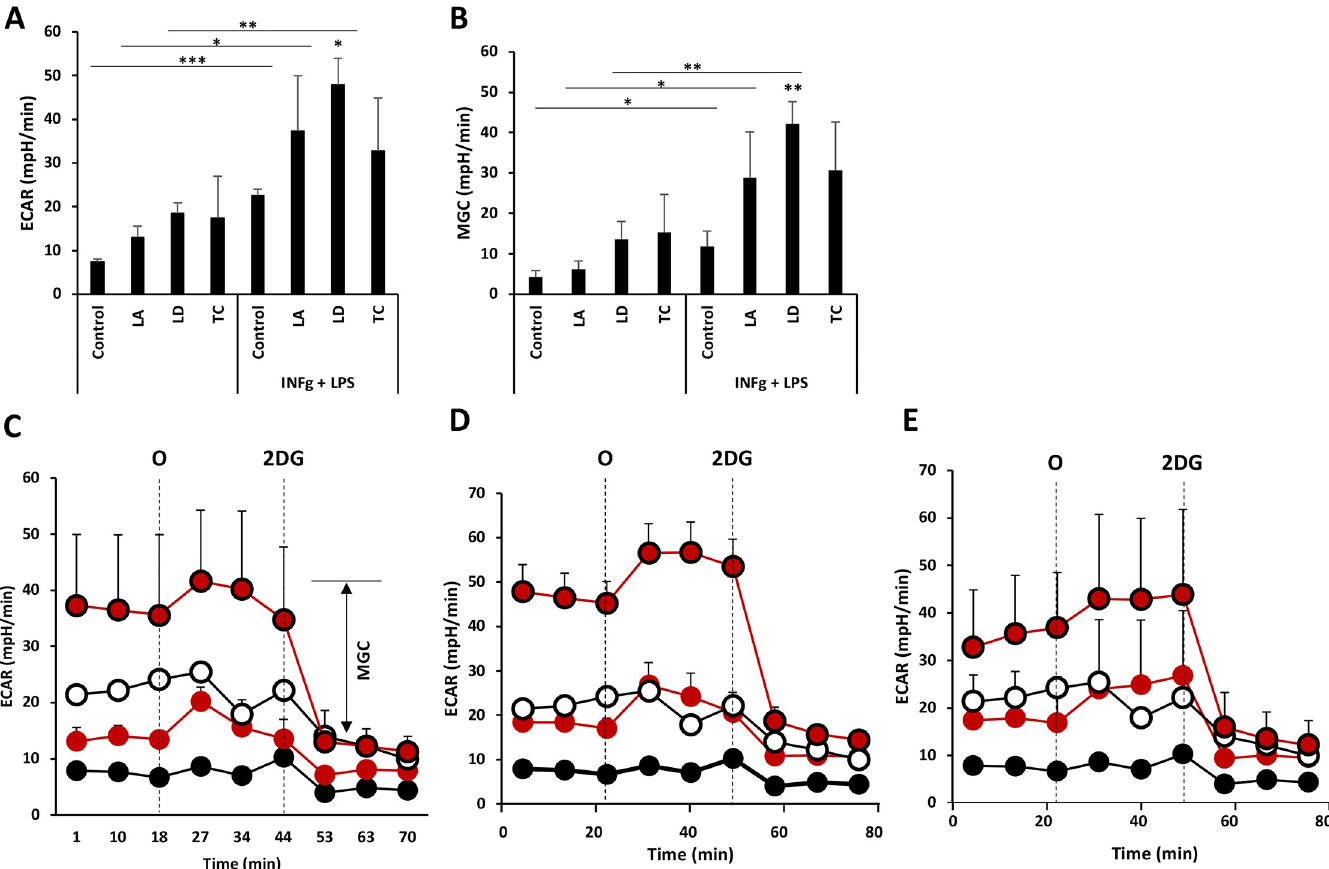
Fig 1. L . amazonensis , L . donovani and T . cruzi infection do not increase basal or maximal glycolytic capacity of macrophages. Glycolytic capacity in the presence of glucose as measured by ECAR (A) and maximal glycolytic capacity (MGC) (B) of macrophages infected with the indicated parasites for 18 h and treated or not with IFN- γ +LPS 6 h before starting Seahorse determinations. (C-E) Real-time changes in ECAR of macrophages infected with L . amazonensis (C), L . donovani (D) or T . cruzi (E) after treatment with oligomycin (O) (1 μ M) and 2-deoxy-glucose (2DG) (50 mM). Parasite-infected macrophages are shown in red circles and IFN- γ +LPS stimulation in bold edges. MGC (double-headed arrow), is shown in (C). Average and standard deviation of triplicates from one experiment are shown. � p < 0.05, �� p < 0.01 and ��� p < 0.001 by one-way ANOVA compared with control or IFN- γ +LPS control. Stars on lines indicate ANOVA comparison of IFN- γ +LPS treated cells to unstimulated ones. Independent stars indicate ANOVA comparison of cells infected with each parasite to control uninfected cells. One representative experiment out of 2 is